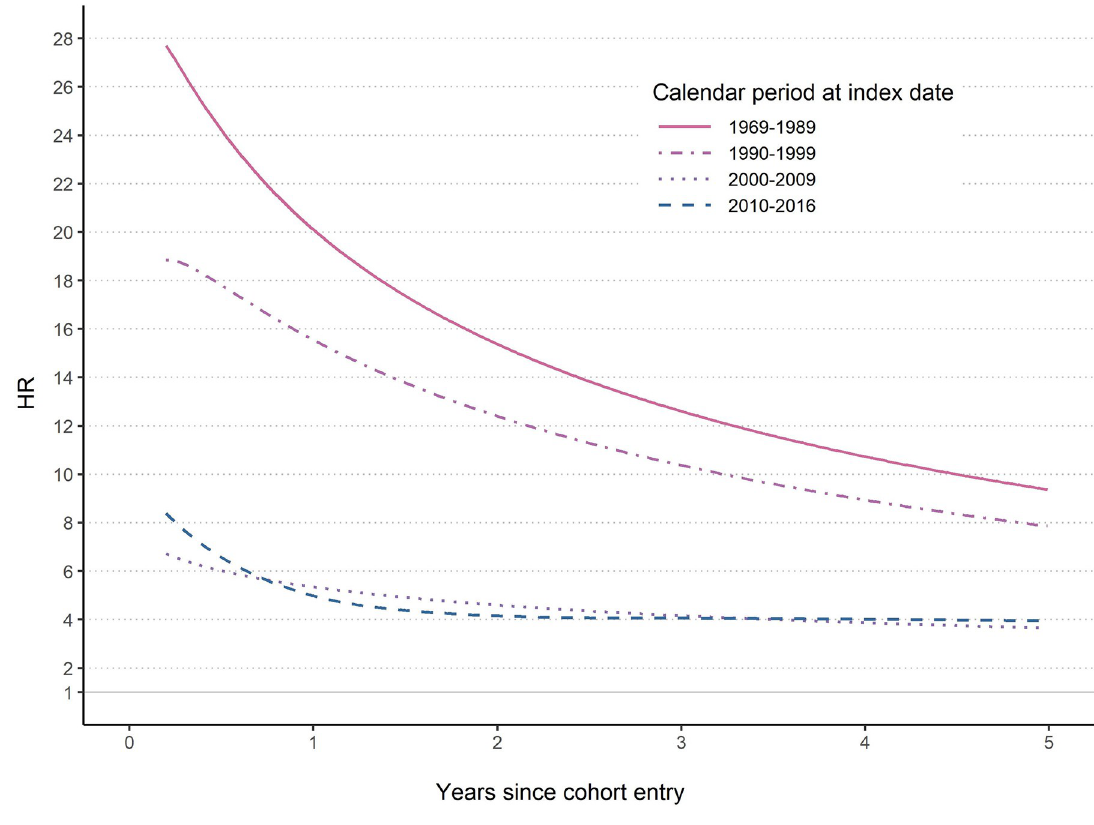
Fig 3. HR of overall IBD as a function of time since biopsy, comparing individuals with a lower GI biopsy result of normal mucosa with their matched population references, stratified by the calendar period at index date. Date of cohort entry was defined as 6 months after the index date. GI, gastrointestinal; HR, hazard ratio; IBD, inflammatory bowel disease.